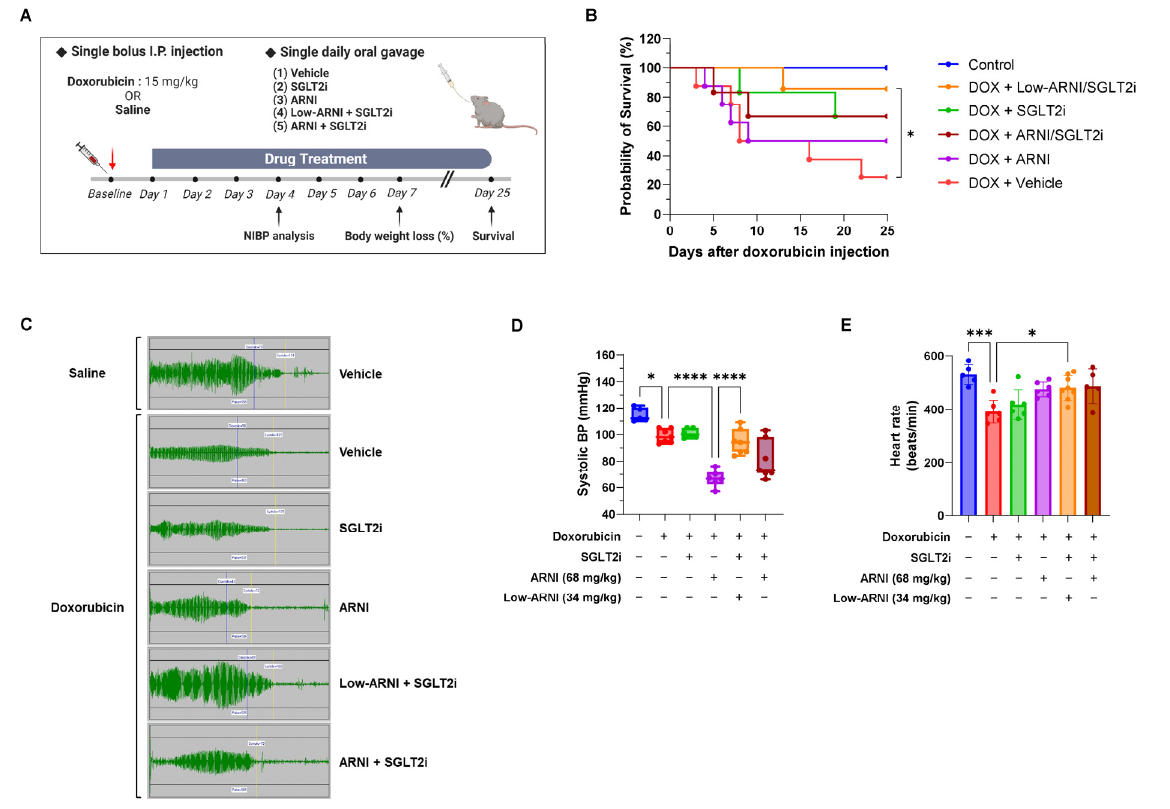
Figure 1. Survival gains and the hemodynamic effects of ARNI and SGLT2i treatment in acute doxorubicin-injected mice. ( A ) Schematic design of acute heart failure model (15 mg/kg i.p.). ( B ) Survival curves for 25 days after doxorubicin injection in indicated experimental groups ( n = 6–8 per group). ( C ) Representative photoplethysmography at 4 days after doxorubicin injection. ( D ) Systolic blood pressure ( n = 5–7 per group). ( E ) Heart rate at 4 days after doxorubicin injection ( n = 5–7 per group). * p < 0.05, *** p < 0.001, **** p < 0.0001 .